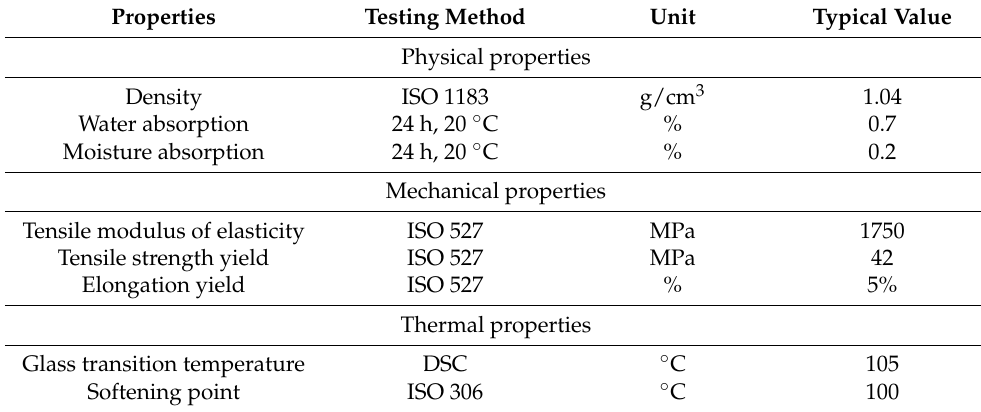
Table 2. The properties of the ABS material used in the research [39].